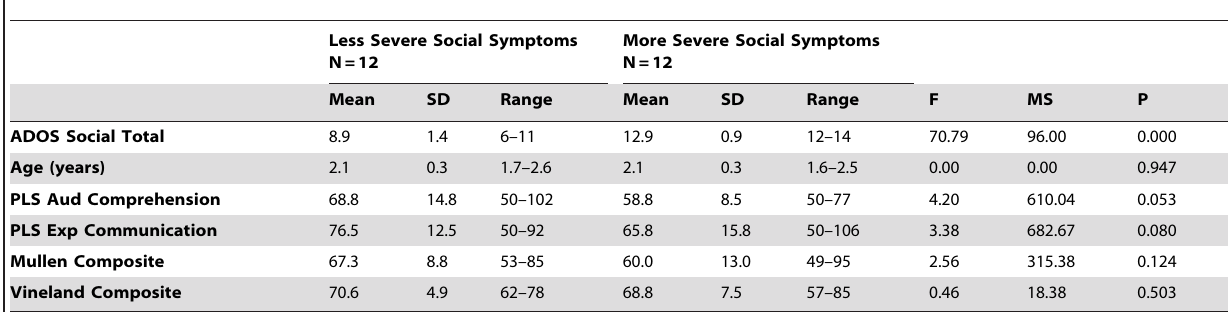
Table 1. Time 1 diagnostic and standardized behavioral measures for subgroups of children with